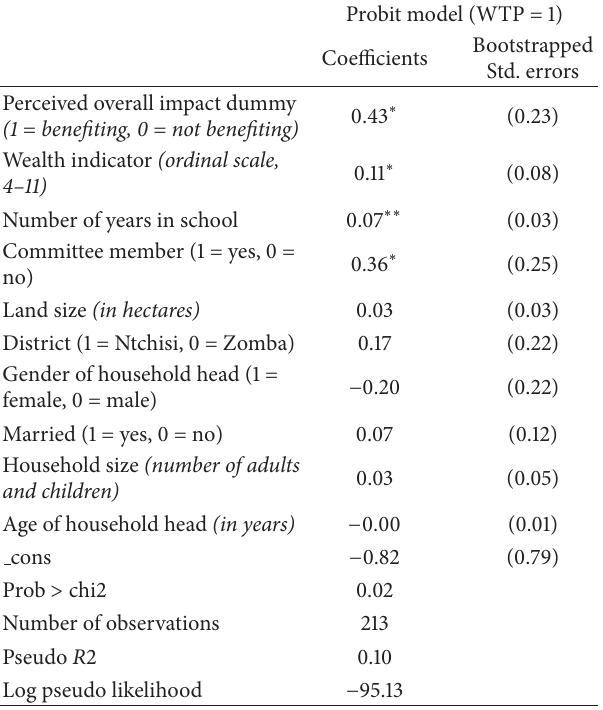
Table 5: Factors affecting households’ willingness to pay a member- ship fee to participate in comanagement programme in Zomba and Ntchisi